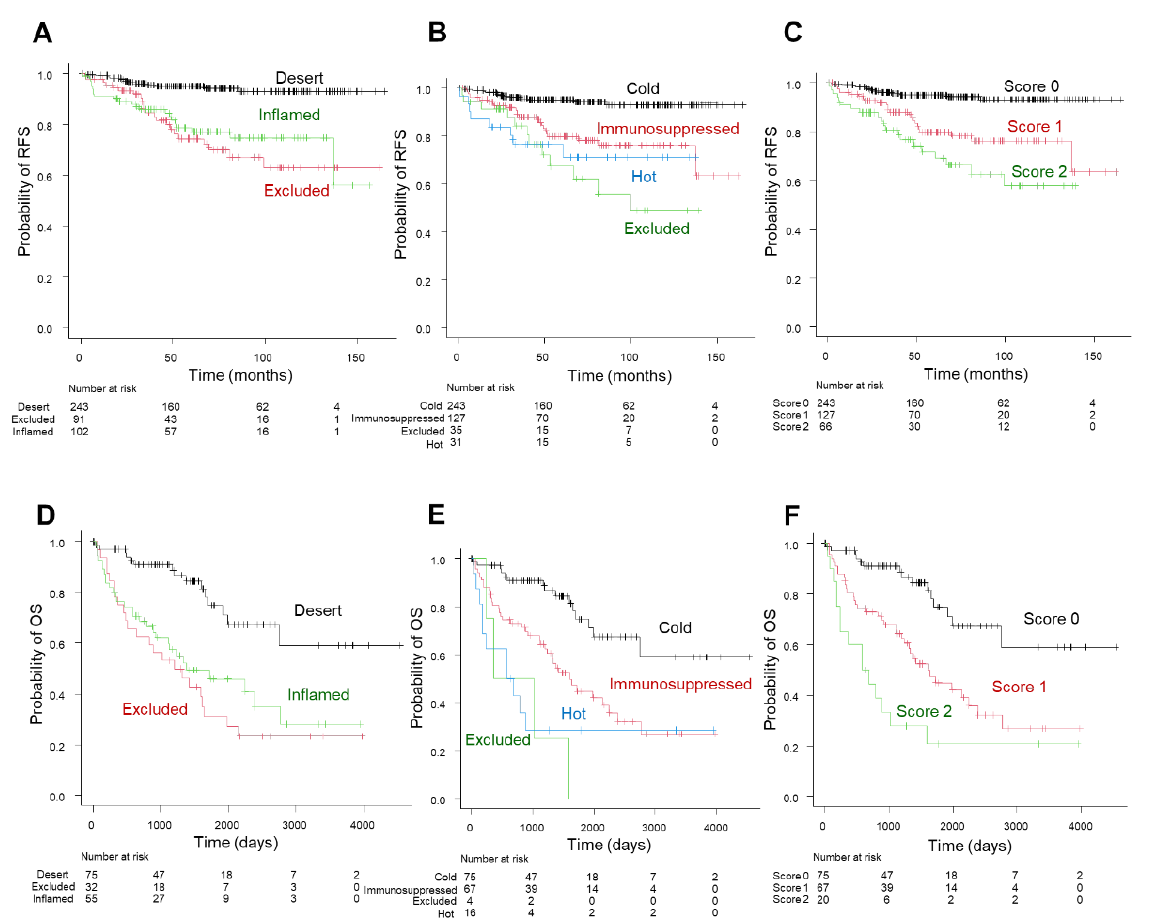
Table 3. Univariate associations with recurrence after nephrectomy in patients with clear cell renal cell carcinoma .